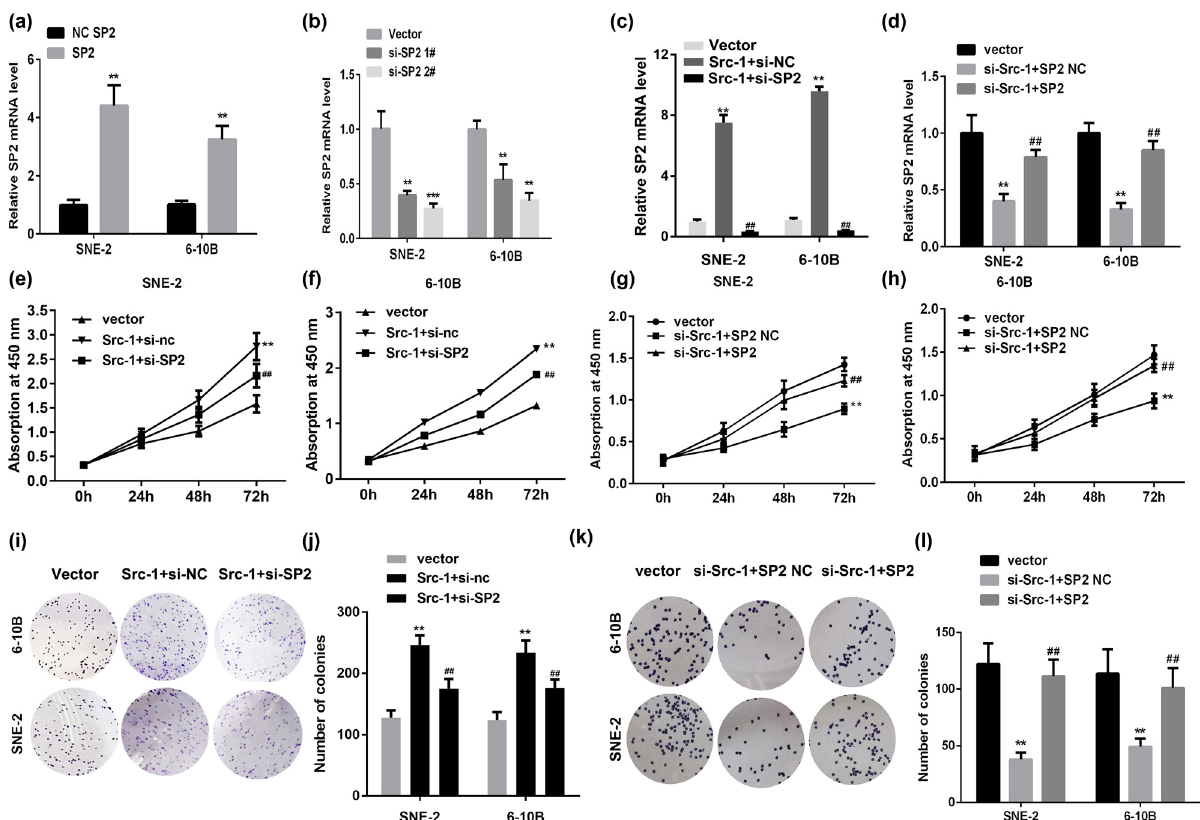
Figure 2: Src - 1 facilitates the cell viability and proliferation of NPC cells via regulating SP2. ( a ) The expression of SP2 determined by qRT - PCR. ( b ) The mRNA level of SP2 detected by qRT - PCR. ( c ) The expression of SP2 determined by qRT - PCR. ( d ) The mRNA level of SP2 detected by qRT - PCR. ( e – h ) Cell viability of NPC cells detected by CCK - 8. ( i – l ) The proliferation of NPCs determined by colony formation assay. ** P < 0.01 vs Vector group. ## P < 0.01. vs Src - 1 + si - NC group or si - Src - 1 + SP2 NC